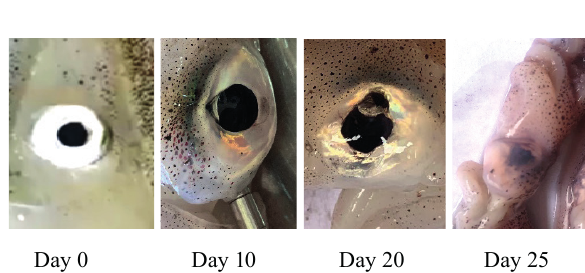
Figure 1 Changes in the skin color during storage